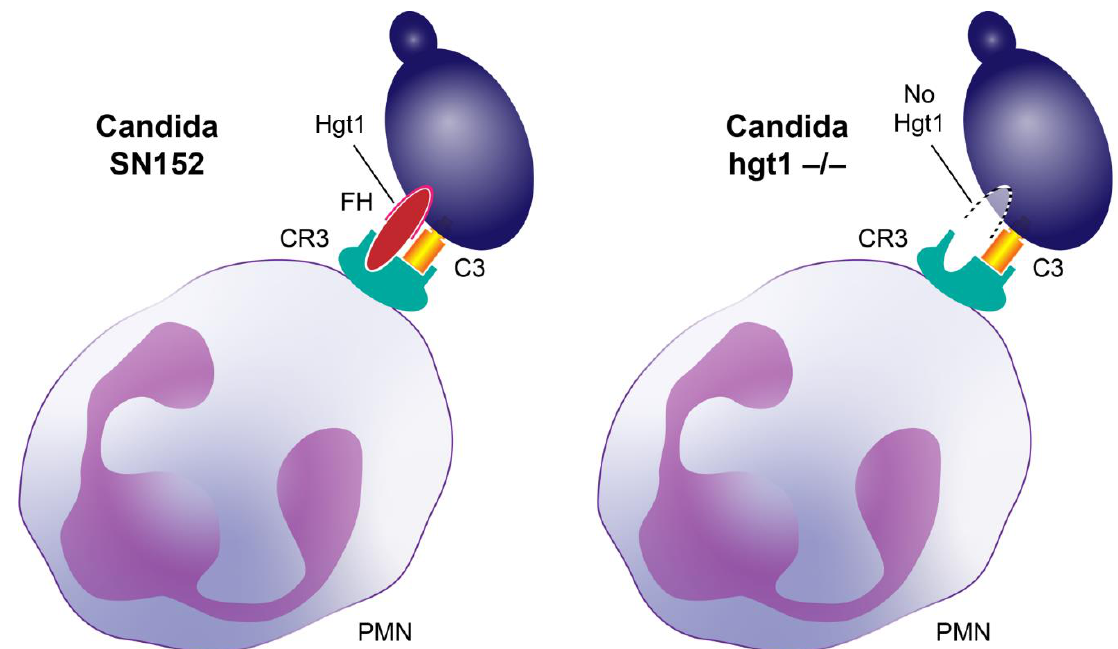
Figure 5. Factor H (FH) bridging Candida albicans cells to professional phagocytes. Both activated C3 (hatched yellow box) and FH (red ellipse) bind to complement receptor 3 (CR3, cyan receptor). Upon opsonization, activated C3 is deposited on Candida albicans (violet cell) and FH binds to its receptor on the yeast (such as Hgt1). Left: binding of Candida albicans parental strain (SN152) to the phagocyte CR3 via both FH and activated C3. Right: Proposed model of an assumed less efficient binding of Candida albicans hgt1-/- mutant lacking an important FH-binding molecule (indicated by dotted line) via just activated C3 to the phagocyte CR3 (in vivo some FH molecules will obviously bind, but with lower affinity).